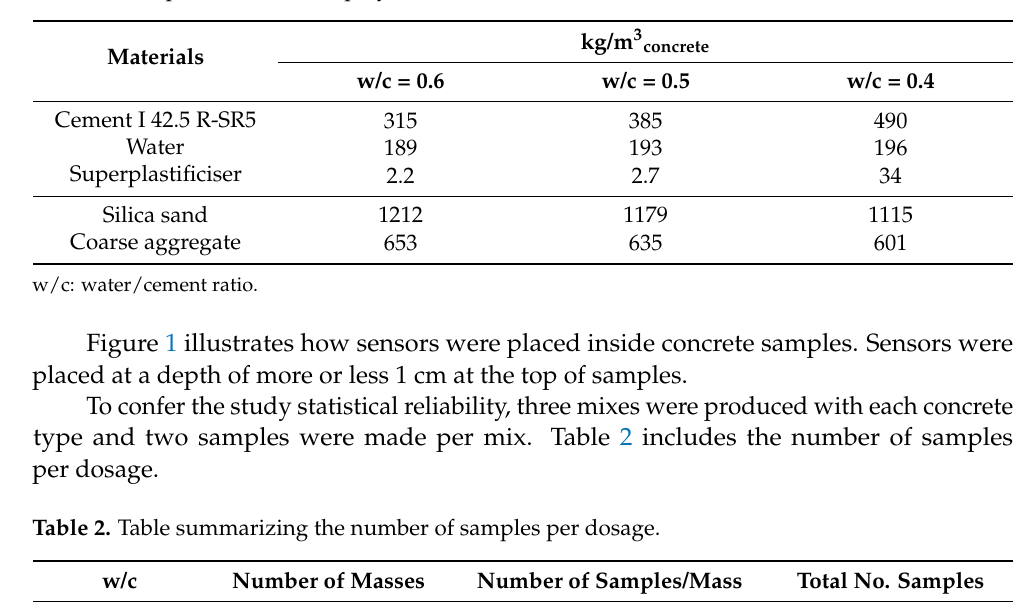
Table 1. Composition of the employed concretes.